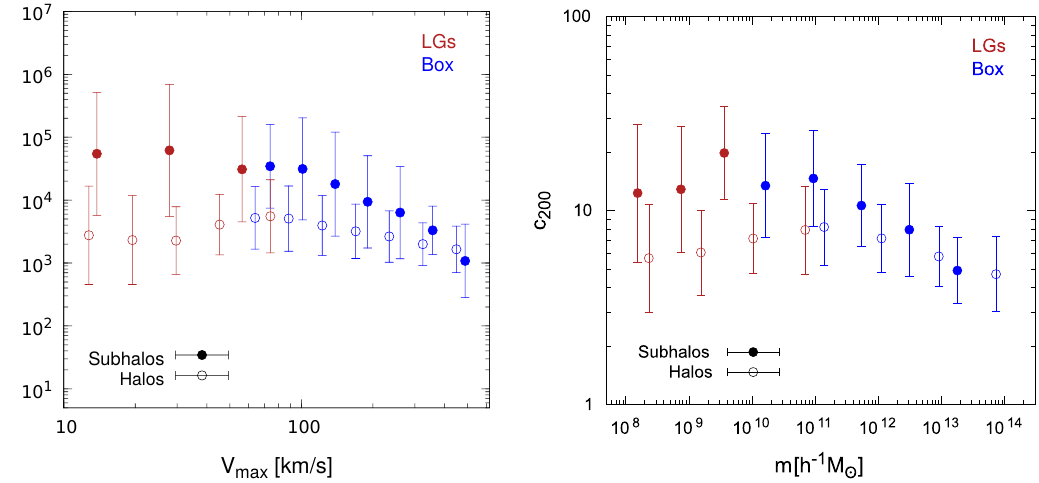
Figure 4. Left panel : Median halo (open circles) and subhalo (filled circles) c V concentration values and corresponding 1 σ errors, as a function of V max , as found in our set of simulations for interacting dark matter (IDM) at z = 0: Box (blue) and LGs (red). Right panel : the same, but for c 200 as a function of m 200